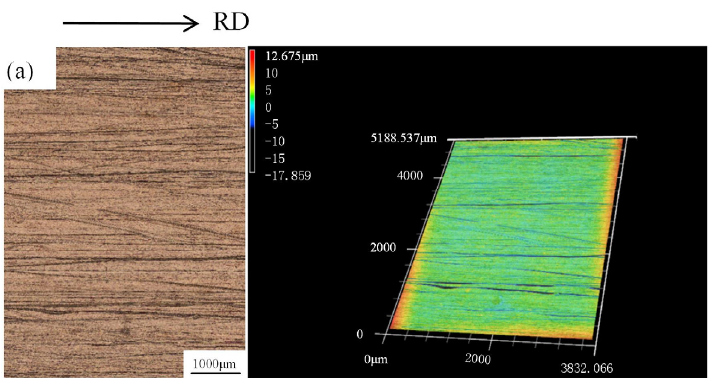
Materials 2022 , 15 , x FOR PEER REVIEW Figure 7. The surface roughness of the rolled copper foils with different reduction ratios during rolling processes: ( a ) Ra and ( b ) Rz.